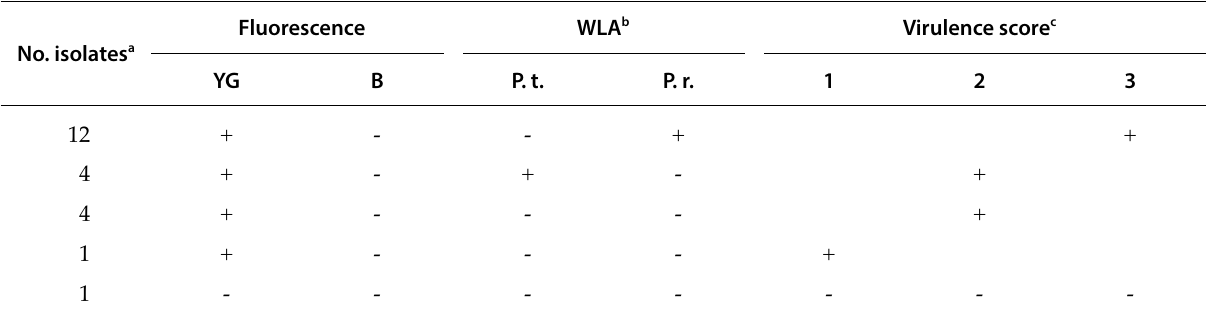
Table 1. Features of the bacterial isolates obtained from brown-reddish blotches surrounded by yellow discoloration on Pleurotus ostreatus sporocarps.